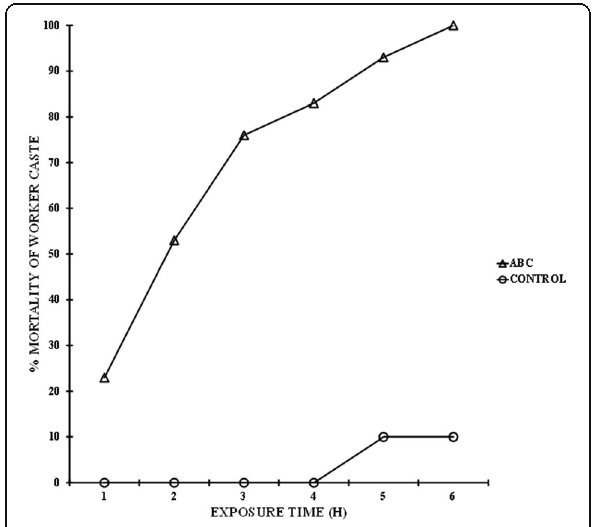
Fig. 2 Percentage mortality of worker caste of Macrotermes subhyalinus (worker) on filter paper treated with tri-mixed aqueous extract. ABC = Azadirachta indica plus Nicotiana tabacum plus Jatropha curcas